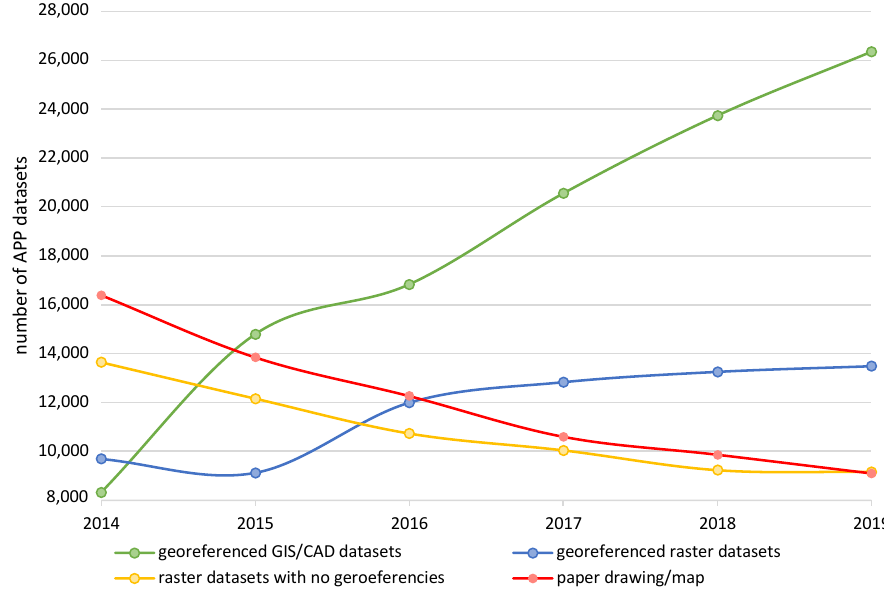
Figure 5. Changes in the level of digitisation of APPs (Spatial Planning Instruments) in Poland, during the period 2014–2019. Source: data from the Ministry of Economic Development, Labour and Technology